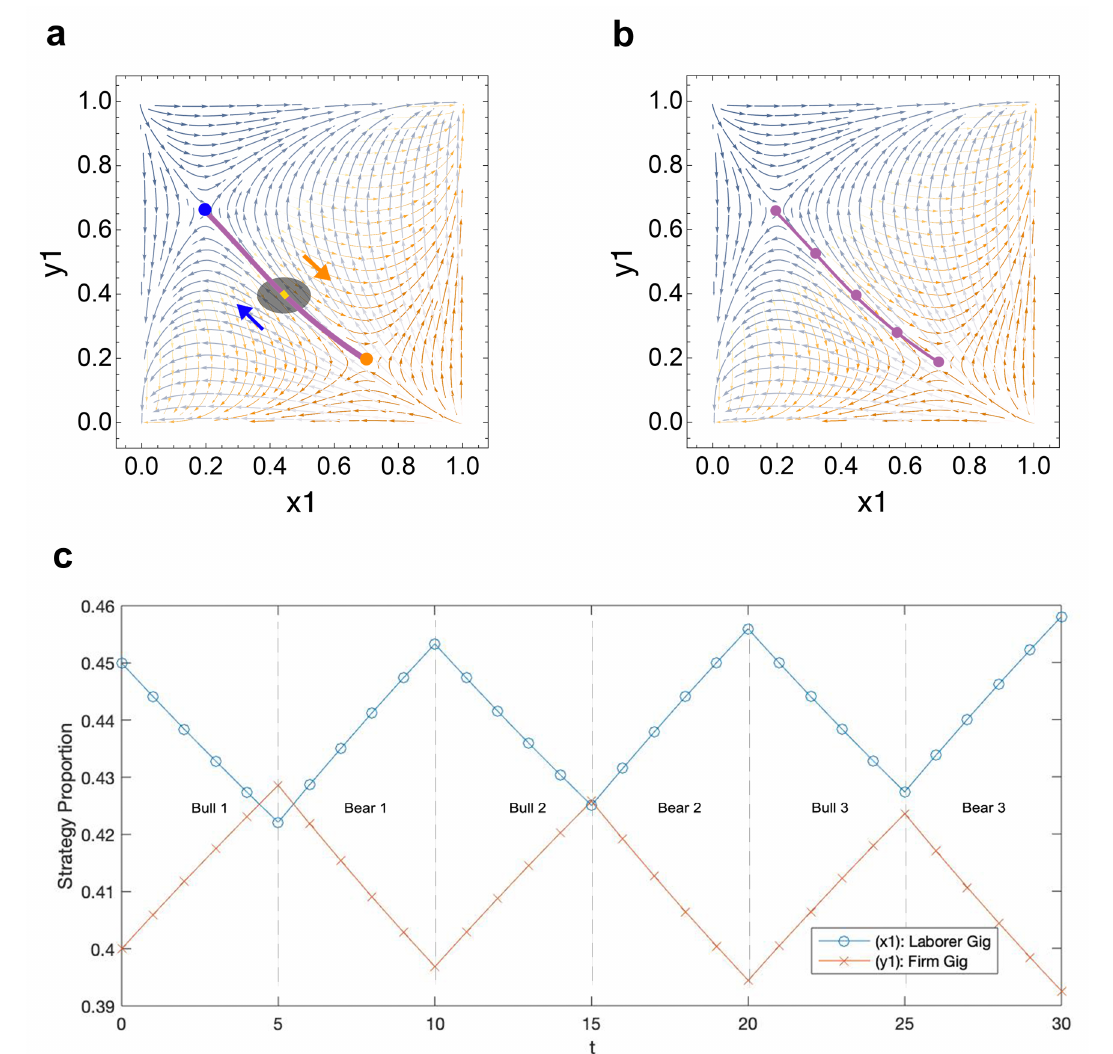
Figure 7. Theoretical market demonstration No. 1: Evolution of strategy densities under market influence with initial conditions ( 0.45,0.40 ) , the attractor position at n = 0.5, an approximation for a point in the trapping zone; n = 1, a bull market; ω = 0.01; and theoretical payoff matrices from Figure 1. ( a ) Trapping zone orbit. ( b ) Attractor arc. ( c ) Labor strategy oscillation over three market periods. In ( a ), the trapping zone orbit is plotted in yellow, and attractor positions at n = 0 and n = 1 are represented in orange and blue, respectively. Directional dynamics during bear and bull markets are represented by the orange and blue arrows, respectively. In ( b ), we plot a reference attractor arc in purple with attractor positions when n = 0, n = 0.25, n = 0.5, n = 0.75 and n = 1. ( c ) visualizes the fluctuation in firm and laborer preferences for gig strategies over three market